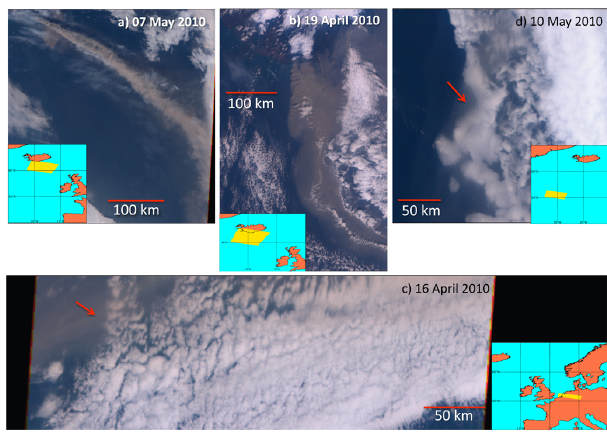
Fig. 1. MISR true color context images, showing the two near- source plumes and the two downwind plumes from the Spring 2010 eruptions used in this study. (a) 7 May 2010 plume, Orbit 55238, Path 216, Blocks 40–42, 12:39UTC, nadir view. (b) 19 April 2010 plume, Orbit 54976, Path 218, Blocks 39–42, 12:51UTC, 70 ◦ for- ward view. (c) 16 April 2010 plume, Orbit 54931, Path 197, Block 49, 10:45UTC, 70 ◦ forward view. (d) 10 May 2010 plume, Or- bit 55282, Path 221, Blocks 49–50, 13:13UTC, 70 ◦ forward view. Inserts show the approximate geographic location of the imagery, north is roughly toward the top, and arrows on the downwind pan- els highlight plume